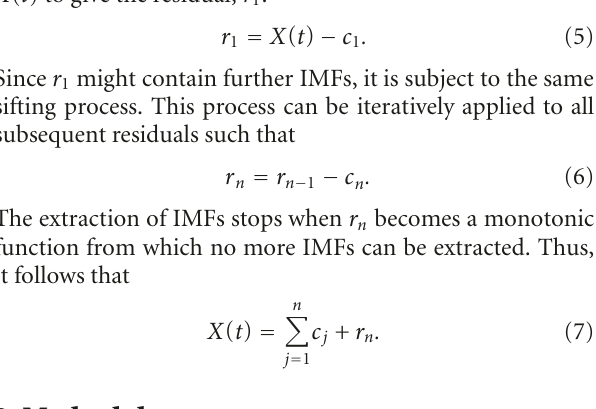
Figure 1: Scaled and smoothed version of an ERP called the P300 obtained by averaging 48 target trials from a visual oddball experiment [3].